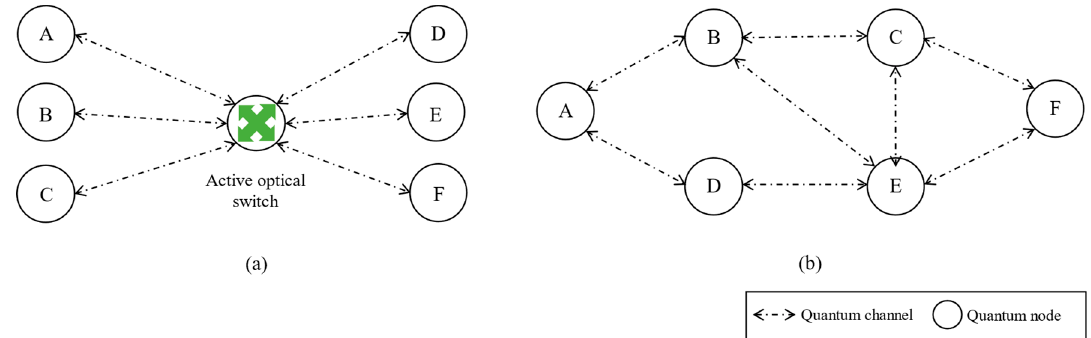
Figure 3. Active optical switch network and trusted node network, in which ( a ) presents the schematic diagram of active optical switch based QKD network and ( b ) presents the schematic diagram of a trusted QKD network.